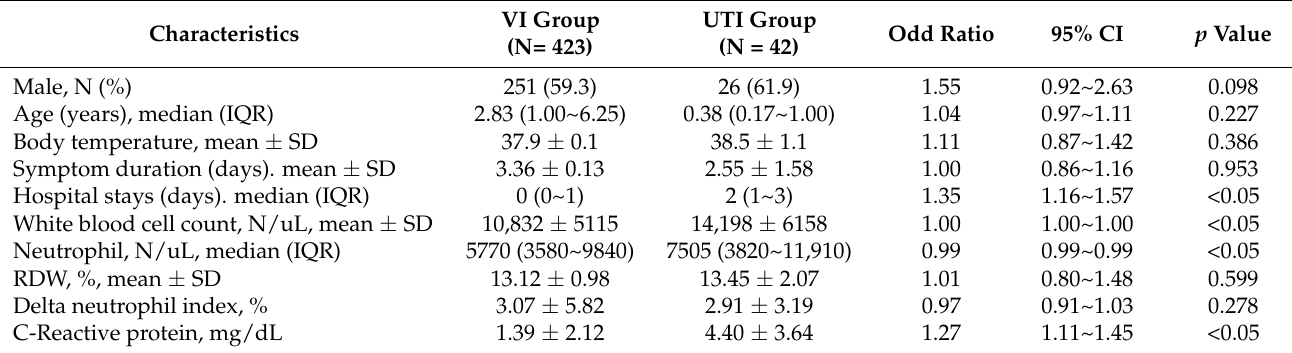
Figure 2. The AUROC of DNI was 0.4948, and the AUROC of CRP was 0.7389. The AUROC of WBC, neutrophils and RDW was 0.5546, 0.5558, and 0.5129, respectively. Only CRP was effective in distinguishing pediatric febrile patients with BIWB from those with VI ( 1 ). When comparing the patients with febrile UTI (42 cases) and the patients with VI (152 cases), WBC and CRP were significantly higher in the UTI group than in the VI group. The AUROCs of WBC, neutrophil, RDW, and CRP were 0.6751, 0.5806, 0.6532, and 0.8117, respectively. The AUROC of DNI was 0.4778, which did not help to differentiate between the two groups ( 2 ). AUROC: Area under ROC; DNI: Delta neutrophil index; CRP: C-reactive protein; WBC: White blood cell count; RDW: Red blood cell distribution width; BIWB: Bacterial infection without bacteremia; VI: Viral infection. Table 2. Sensitivity analysis. Comparison of each inflammatory marker between the UTI vs. viral infection